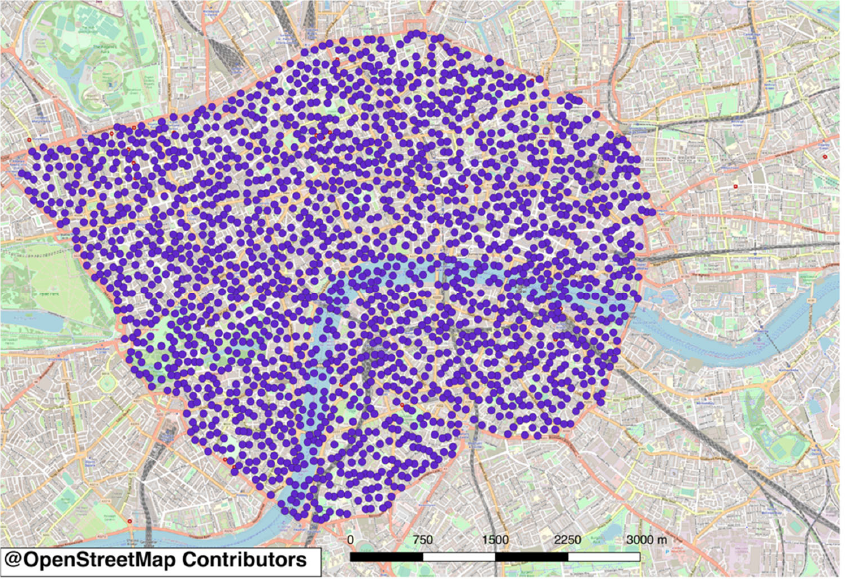
Figure 2. Map of the 2048 CDPs in the study area.